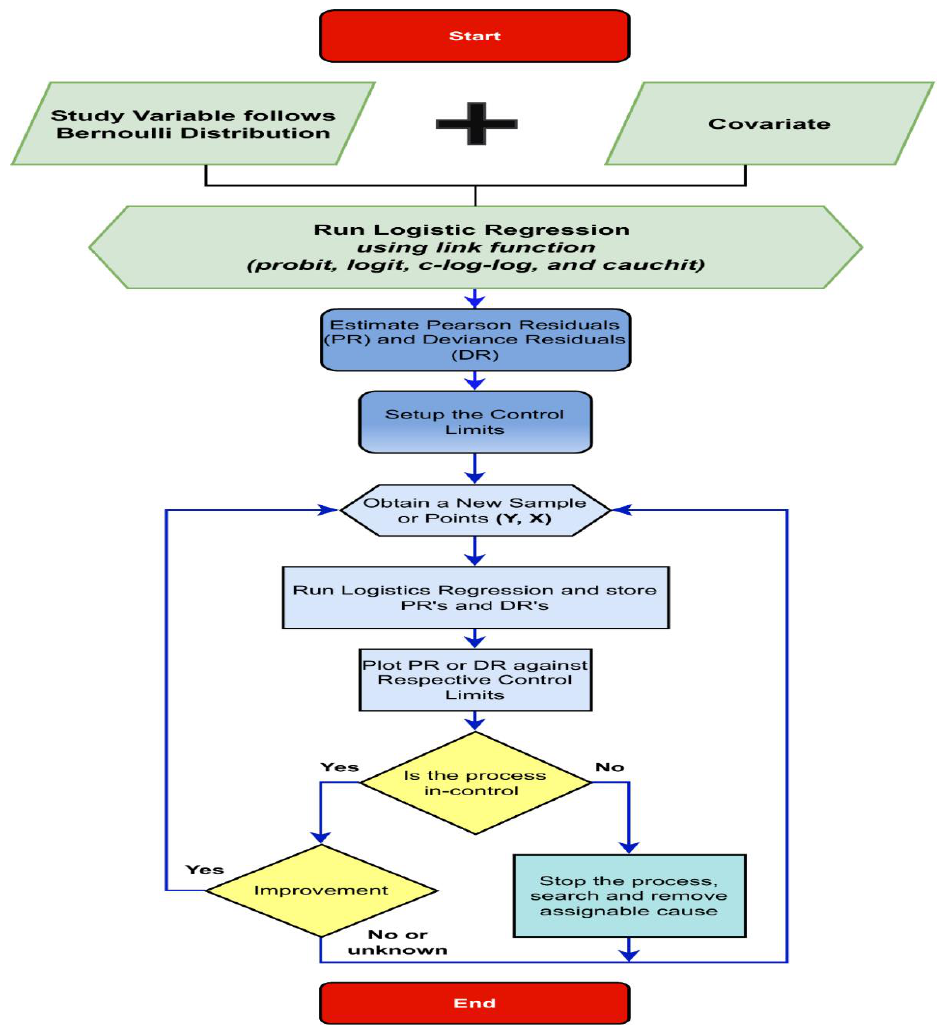
Figure 1. Follow chart of the